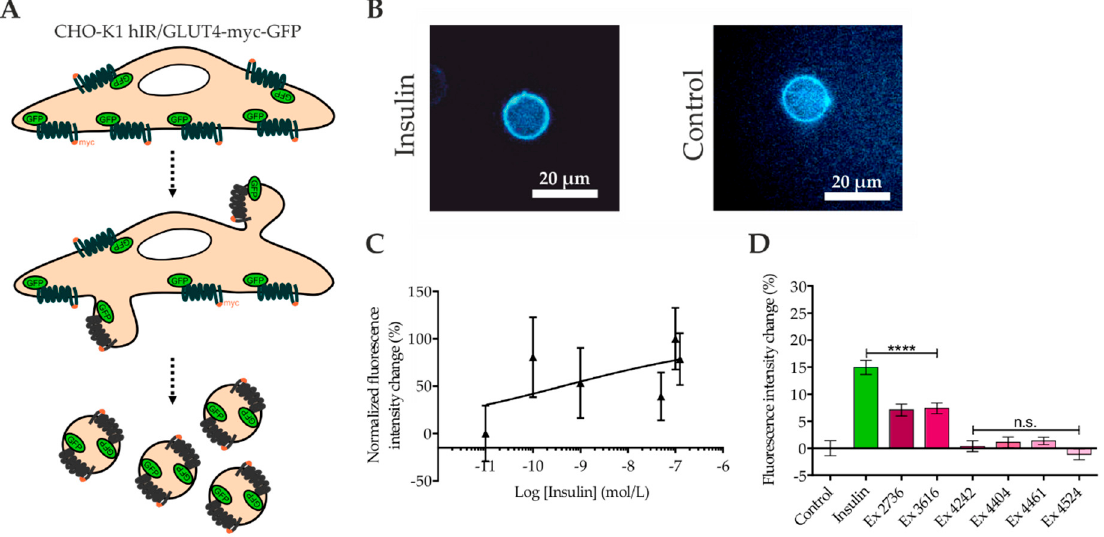
Figure 4. Quantitation of GLUT4 translocation by confocal microscopy of giant plasma membrane vesicles (GPMVs) prepared from CHO-K1 cells stably expressing a GLUT4-myc-GFP fusion protein. These cells were seeded in 96-well microtiter plates, starved for 3 h in HBSS bu ff er on the following day, and incubated with the test substances for 10 min. The cells were washed three times with GPMV bu ff er and incubated for 1 h in GPMV-forming bu ff er. The GPMVs were transferred to empty wells of an imaging plate, and images were taken by confocal microscopy. A schematic illustration of GPMV formation ( A ) and formed GPMVs of the insulin-treated and untreated cells ( B ) is shown. The insulin dose–response curve was generated by quantitation of the fluorescence signal intensity increase induced within 10 min by various insulin concentrations ( C ). Fluorescence intensities of the GPMVs from the cells treated with insulin and the indicated plant extracts were analyzed and normalized to those of the untreated cells ( D ). Values represent the mean ± SEM ( n > 1000). **** p < 0.0001 indicates statistically significant di ff erences from the untreated controls. n.s., not